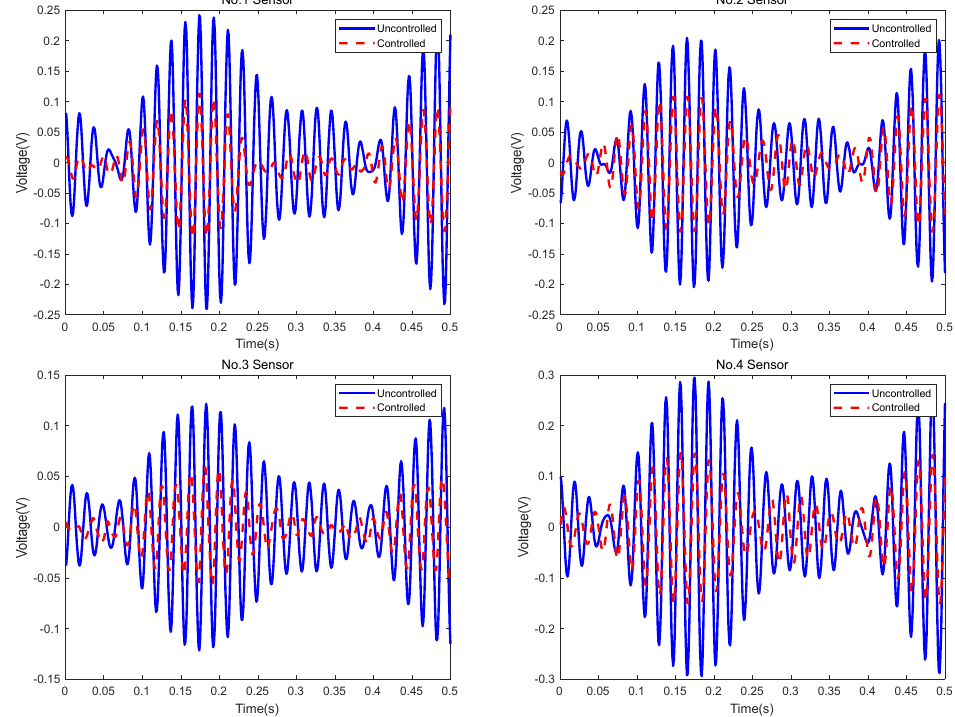
Figure 9. Sensor signals obtained by simulations (1 mV represents 0.1 m/s 2 ). Table 1. RMS values of sensor signals: Simulation #1.